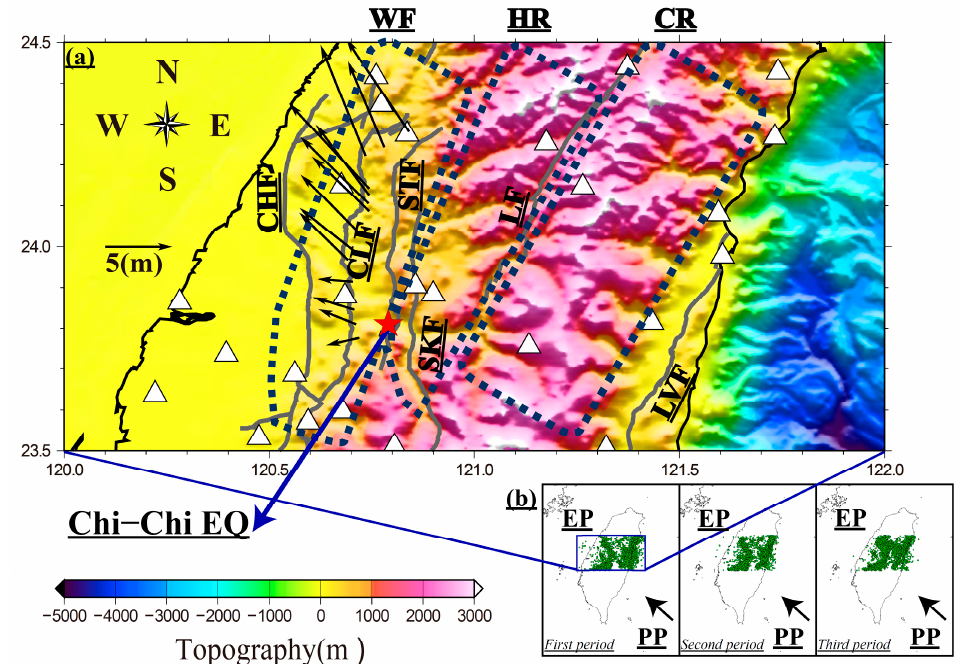
Figure 1. ( a ) Fault setting in central Taiwan and seismic stations used in this study. The black arrows indicate the near-field GPS horizontal coseismic displacement. ( b ) Seismic distributions at different time periods. In the period I, there were 6075 events and 93,870 ray paths within the study area. In the period II, there were 5970 events and 96,862 ray paths within the study area. In the period II, there were 8234 events and 135,391 ray paths within the study area. EP: Eurasian Plate; PP: Philippine Sea Plate; WF: Western Foothills; HR: Hsuehshan Range; CR: Central Range; CHF: Changhua Fault; CLF: Chelungpu Fault; STF: Shuangtung Fault; SKF: Shuilikeng Fault; LF: Lishan Fault; LVF: Longitudinal Valley Fault.